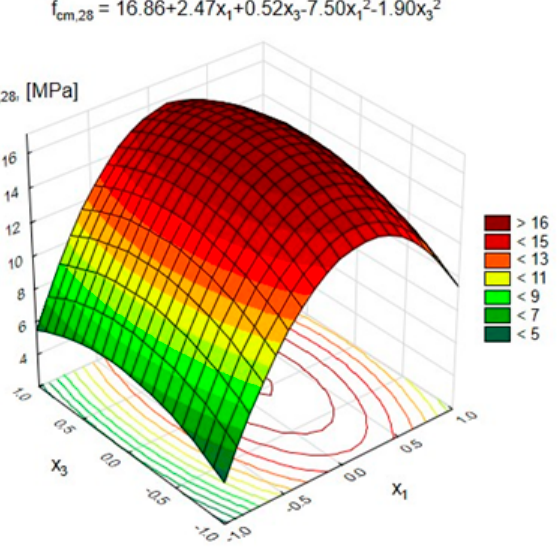
1 and x 2 at x 3 = 0 (10 M).